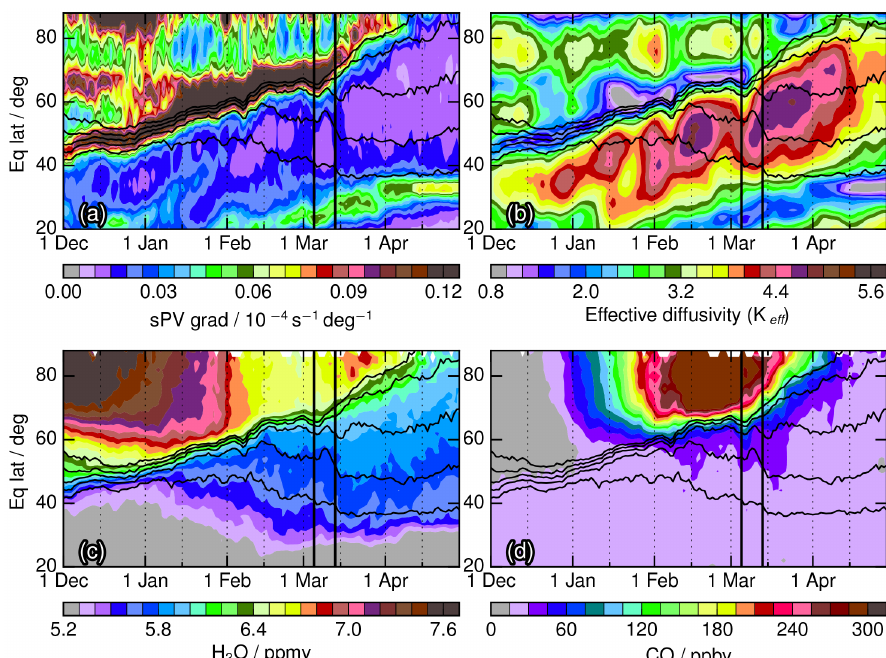
Figure 5. Equivalent latitude–time series at 850K for 2015/16 showing MERRA-2 (a) sPV gradients and (b) effective diffusivity ( K eff ), as well as MLS (c) H 2 O and (d) CO. Black contours show sPV values of 1.0, 1.2, 1.4, 1.6, and 1.8 × 10 − 4 s − 1 in the vortex edge region. The vertical black lines indicate the onset day of the MFW and the following vortex